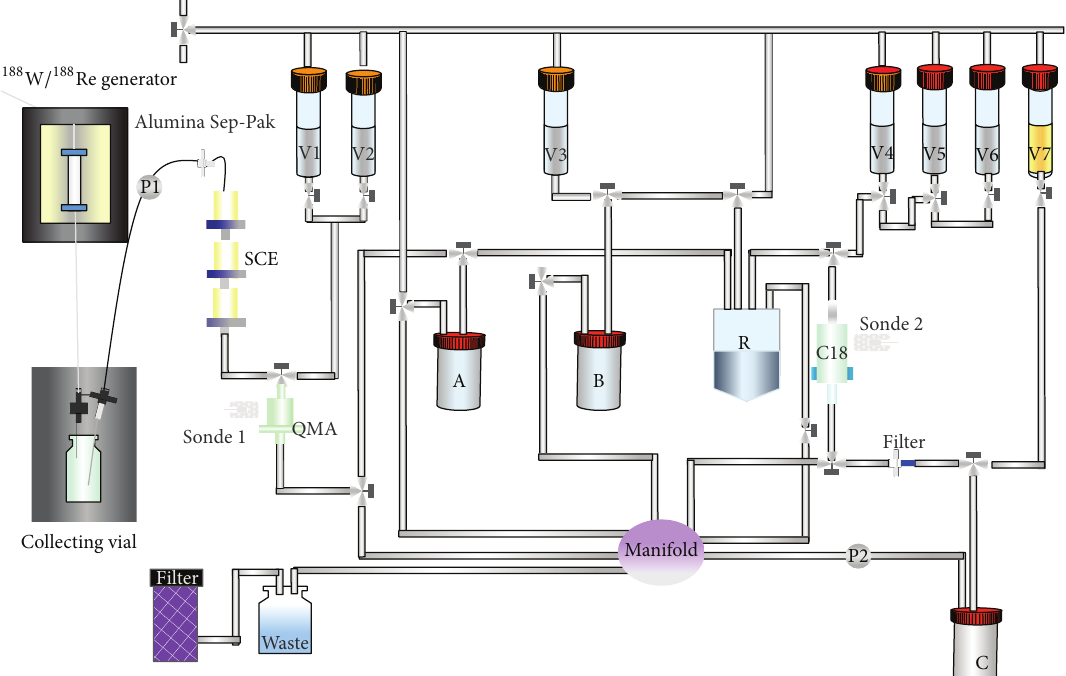
Figure 9: Flowchart illustrating the automated system for the preparation of 188 Re-lipiodol